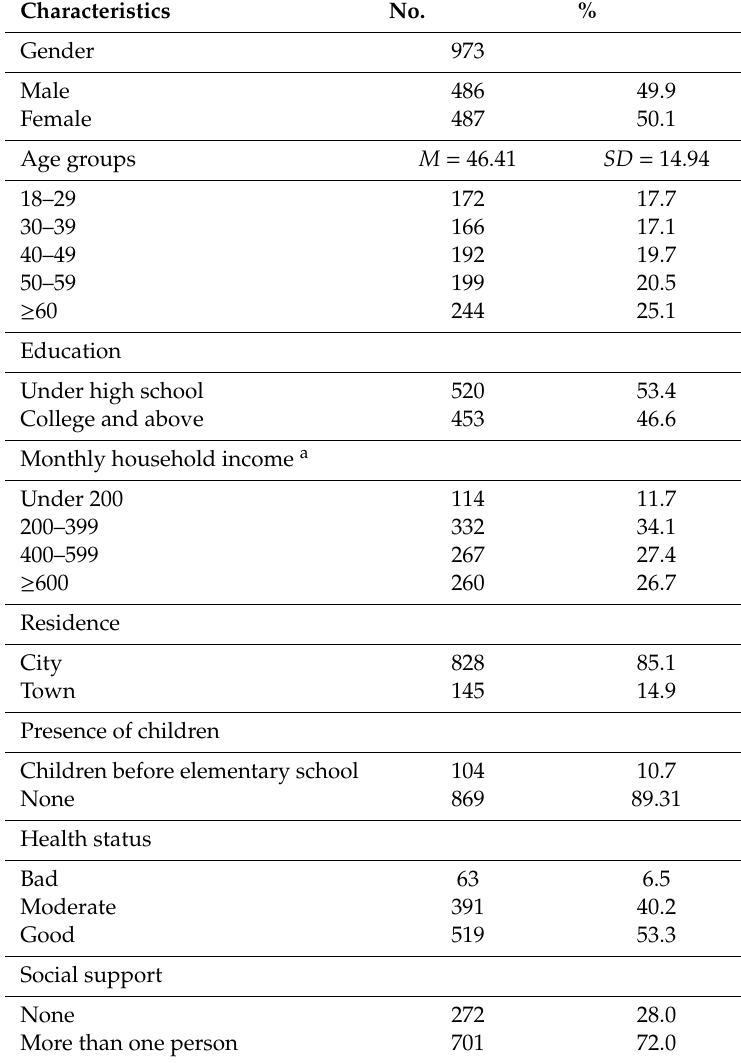
Table 1. Descriptive statistics of survey respondents ( n =